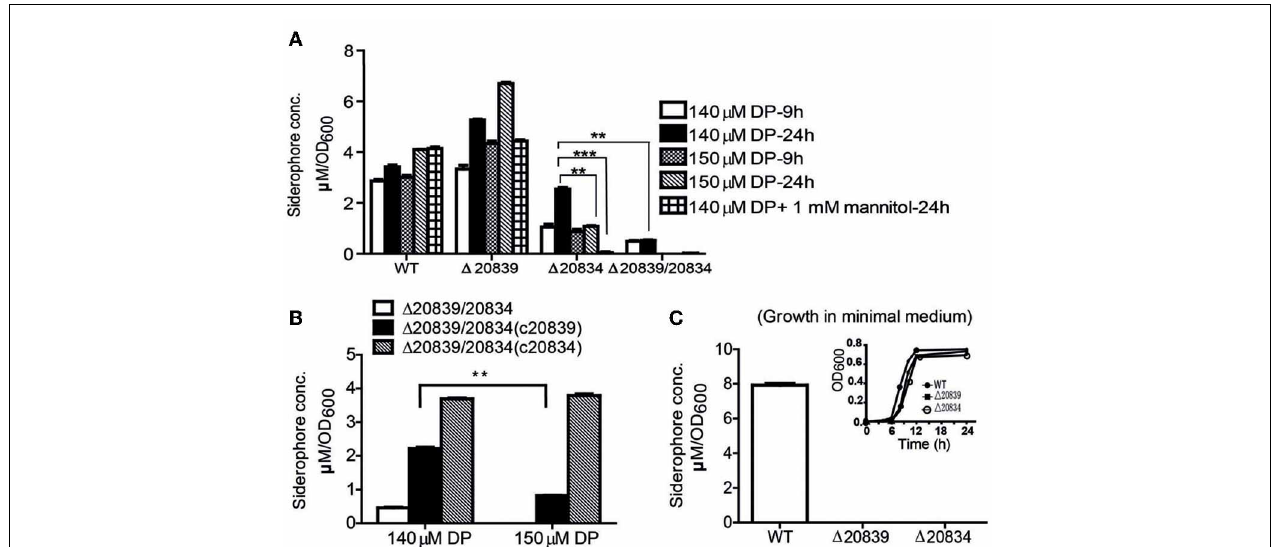
FIGURE 3 | Siderophore production measurement by Arnow test. (A) WT and mutants were grown in 2.5% NaCl-HI supplemented with 140 or 150 μ M DP for 9 or 24h. In some experiments mannitol (1mM) was added along with DP. (B) Siderophore levels produced by double mutant and its single gene complemented strains grown in 2.5% NaCl-HI with added DP. (C)